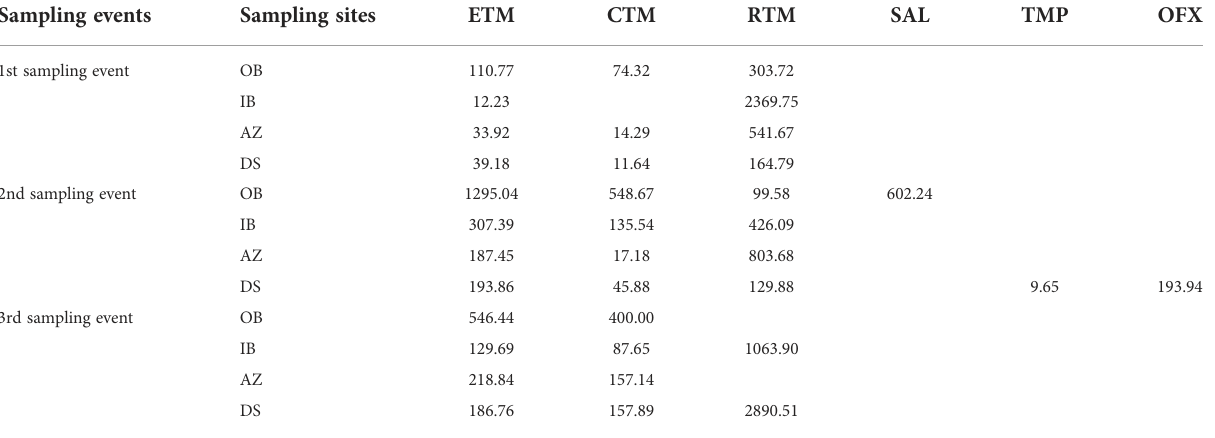
TABLE 1 The pseudo-partitioning coef fi cients of target antibiotics in this